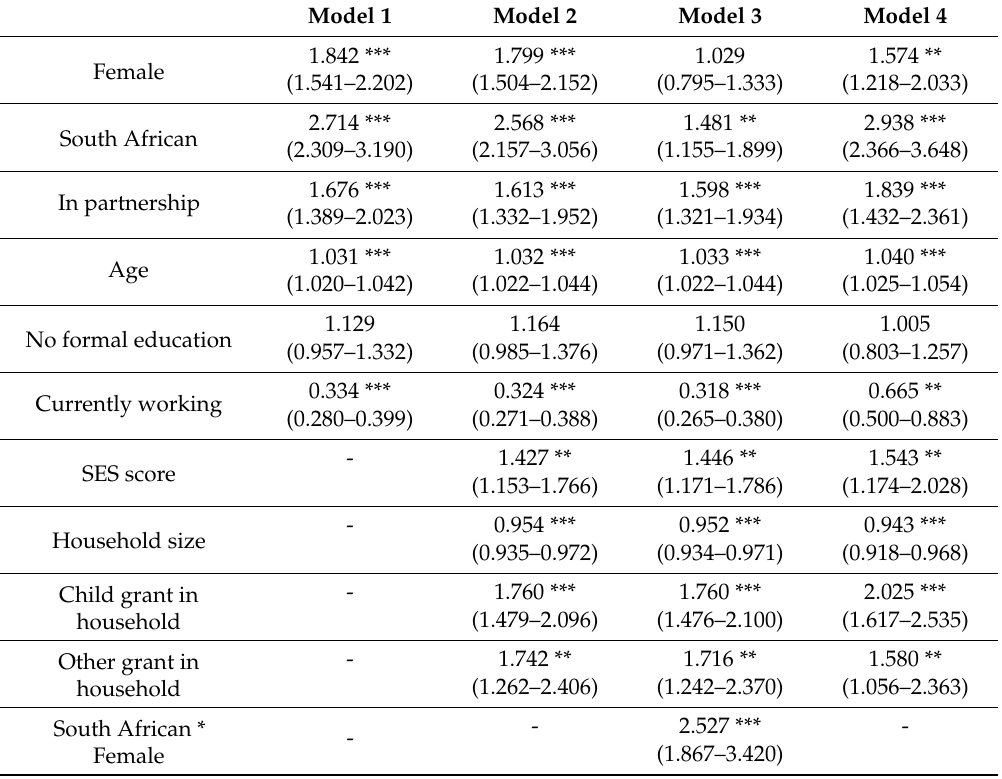
Figure 1. Distribution of socioeconomic status for persons 60 years and older by reported pension receipt, Agincourt HDSS 2010; N = 4915. Table 4. Logistic regression odds ratios and (95% CI) predicting reported pension receipt for adults 60+, Agincourt HDSS and WHO-SAGE 2010.